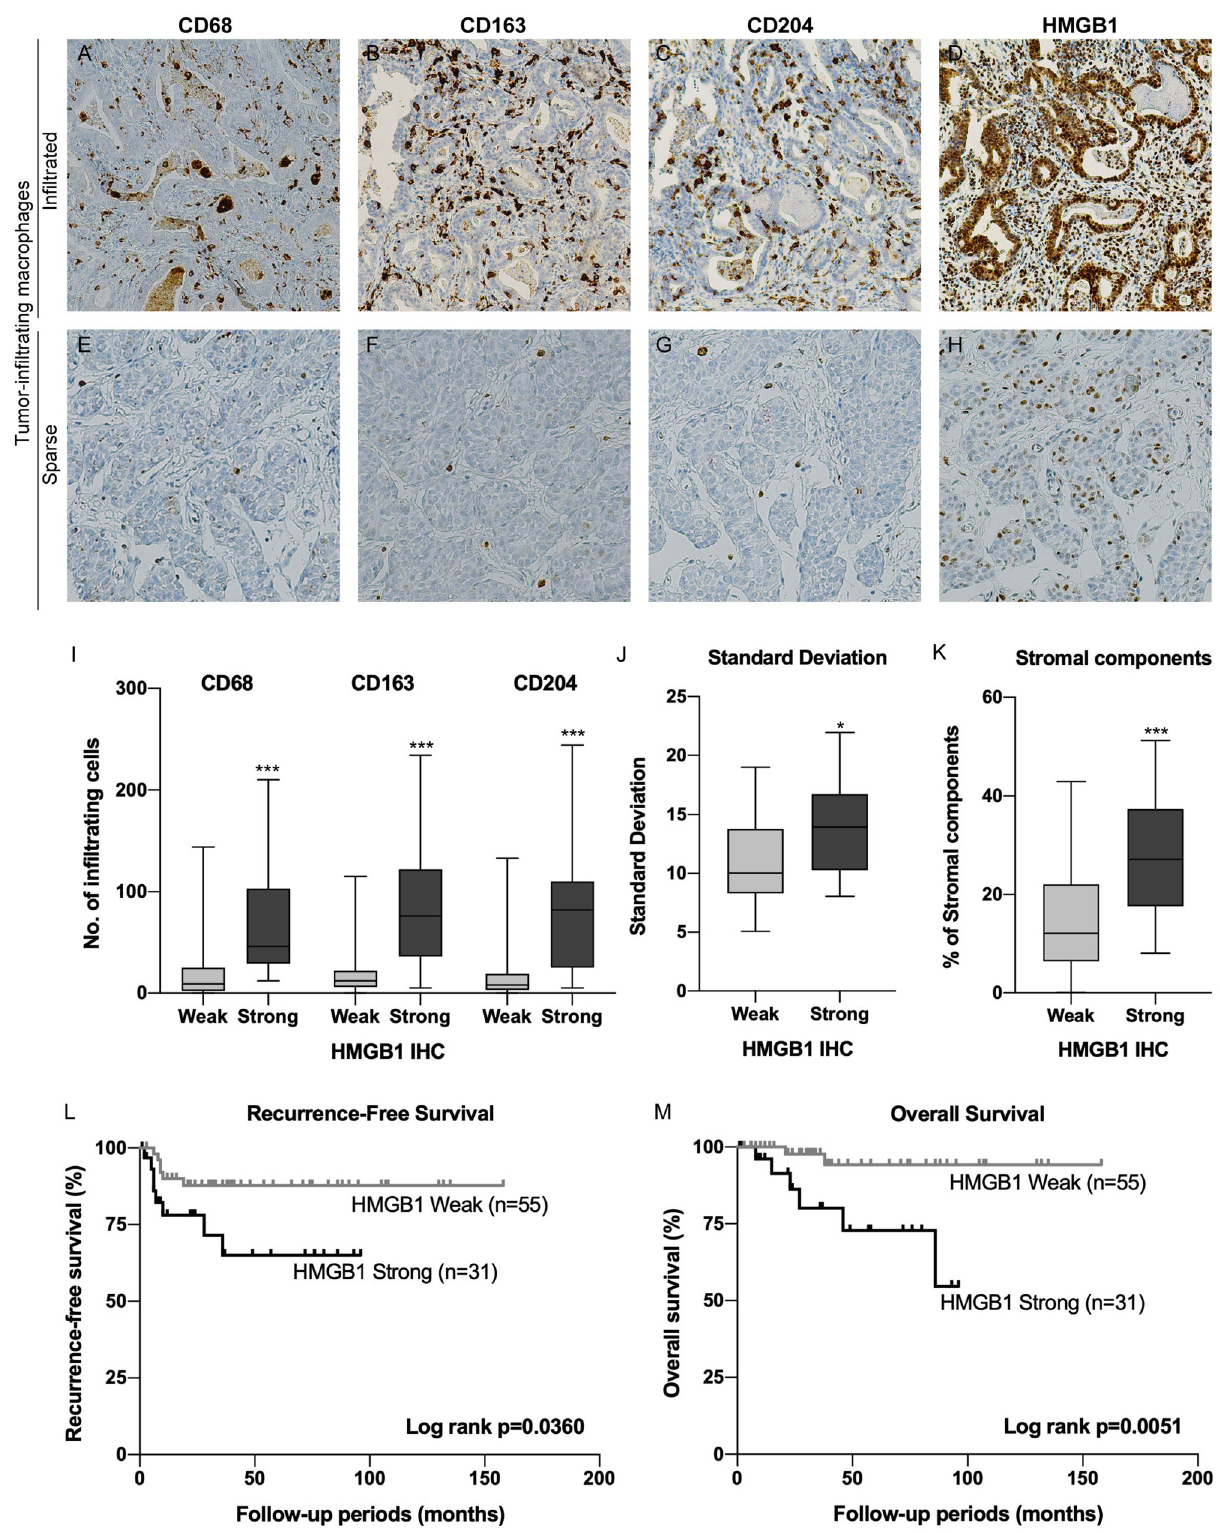
Figure 5. HMGB1 expression was associated with tumor heterogeneity and macrophage infiltration in UTUC. Representative cases of UTUC with abundant macrophage ( A – D ) and sparse macrophage infiltration ( E – H ). The tumor with more infiltrating CD68- ( A ), CD163- ( B ) and CD204- ( C ) positive macrophages showed strong HMGB1 expression ( D ). Conversely, the tumor with fewer CD68- ( E ), CD163- ( F ) and CD204- ( G ) positive macrophages showed weak HMGB1 expression ( H ). ( I ) Boxplots for CD68-, CD163- and CD204-positive macrophages according to HMGB1 expression. ( J ) Boxplot for SD according to HMGB1 expression. ( K ) Boxplot for the amount of stromal components according to HMGB1 expression. ( L ) Kaplan–Meier analysis for RFS according to HMGB1 expression. ( M ) Kaplan–Meier analysis for OS according to HMGB1 expression. * p < 0.05, *** p < 0.0001. HMGB1 = high mobility group box 1, UTUC = upper tract urothelial carcinoma, SD = standard deviation, RFS = recurrence-free survival, OS = overall